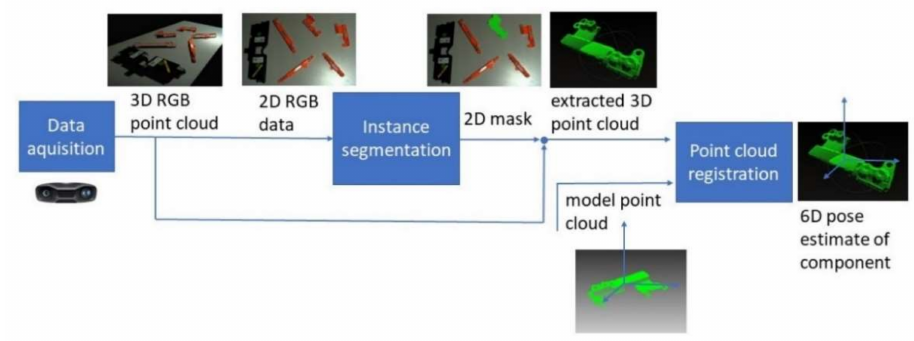
Figure 5. Vision pipeline from image capture to final 6D pose estimation of